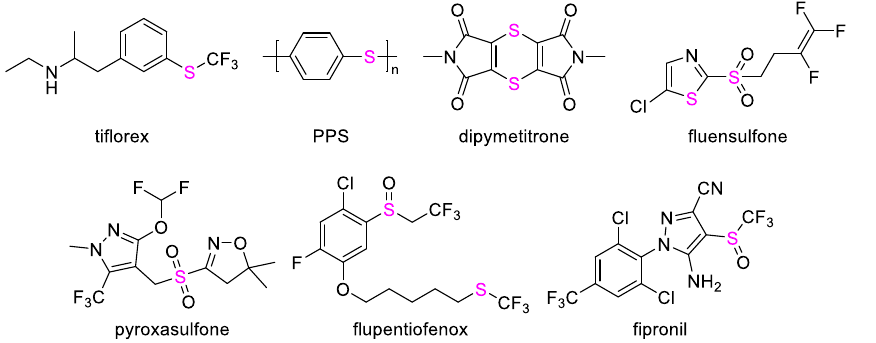
Figure 1. Structures of reported sulfur-containing compounds.